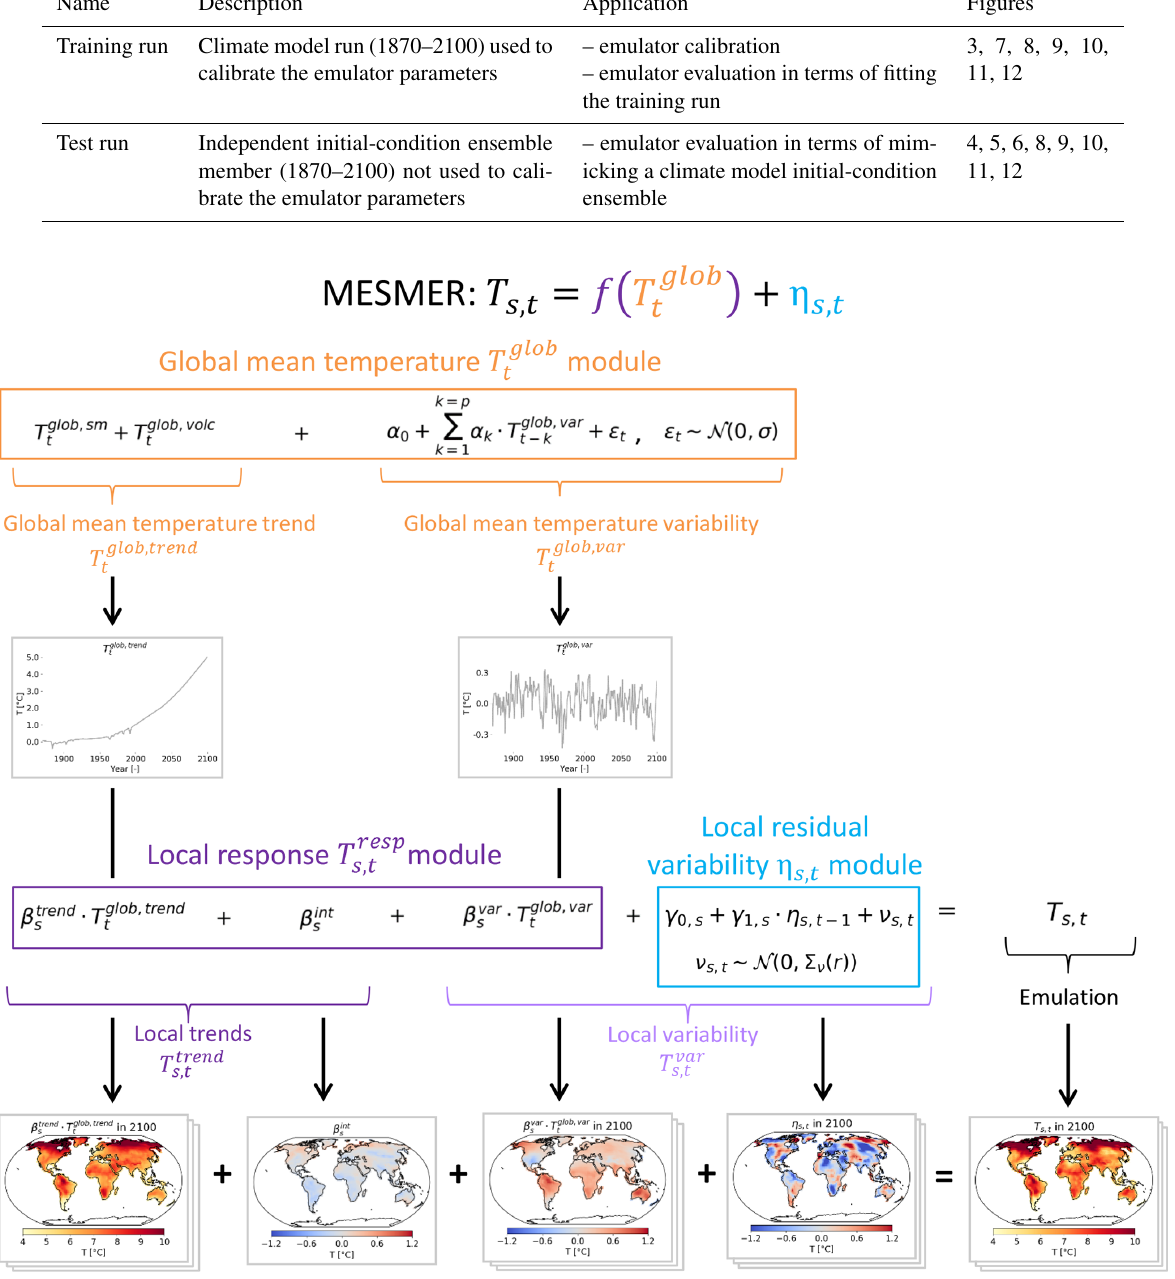
coefficients of the AR process are fit by means of maximum likelihood, and the Bayesian information criterion (BIC) is employed to select its order p with the maximum considered order being